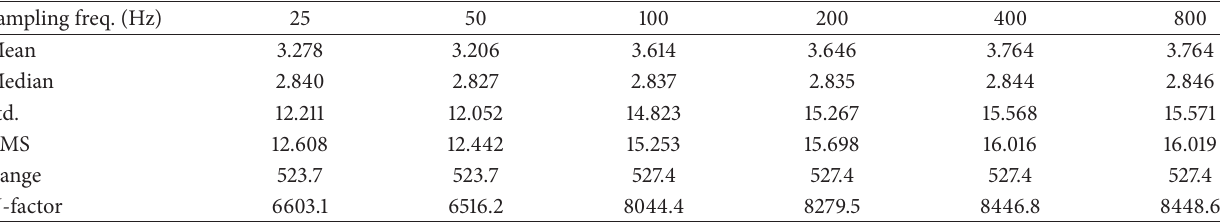
Table 2: Statistical variables for different sampling frequencies.